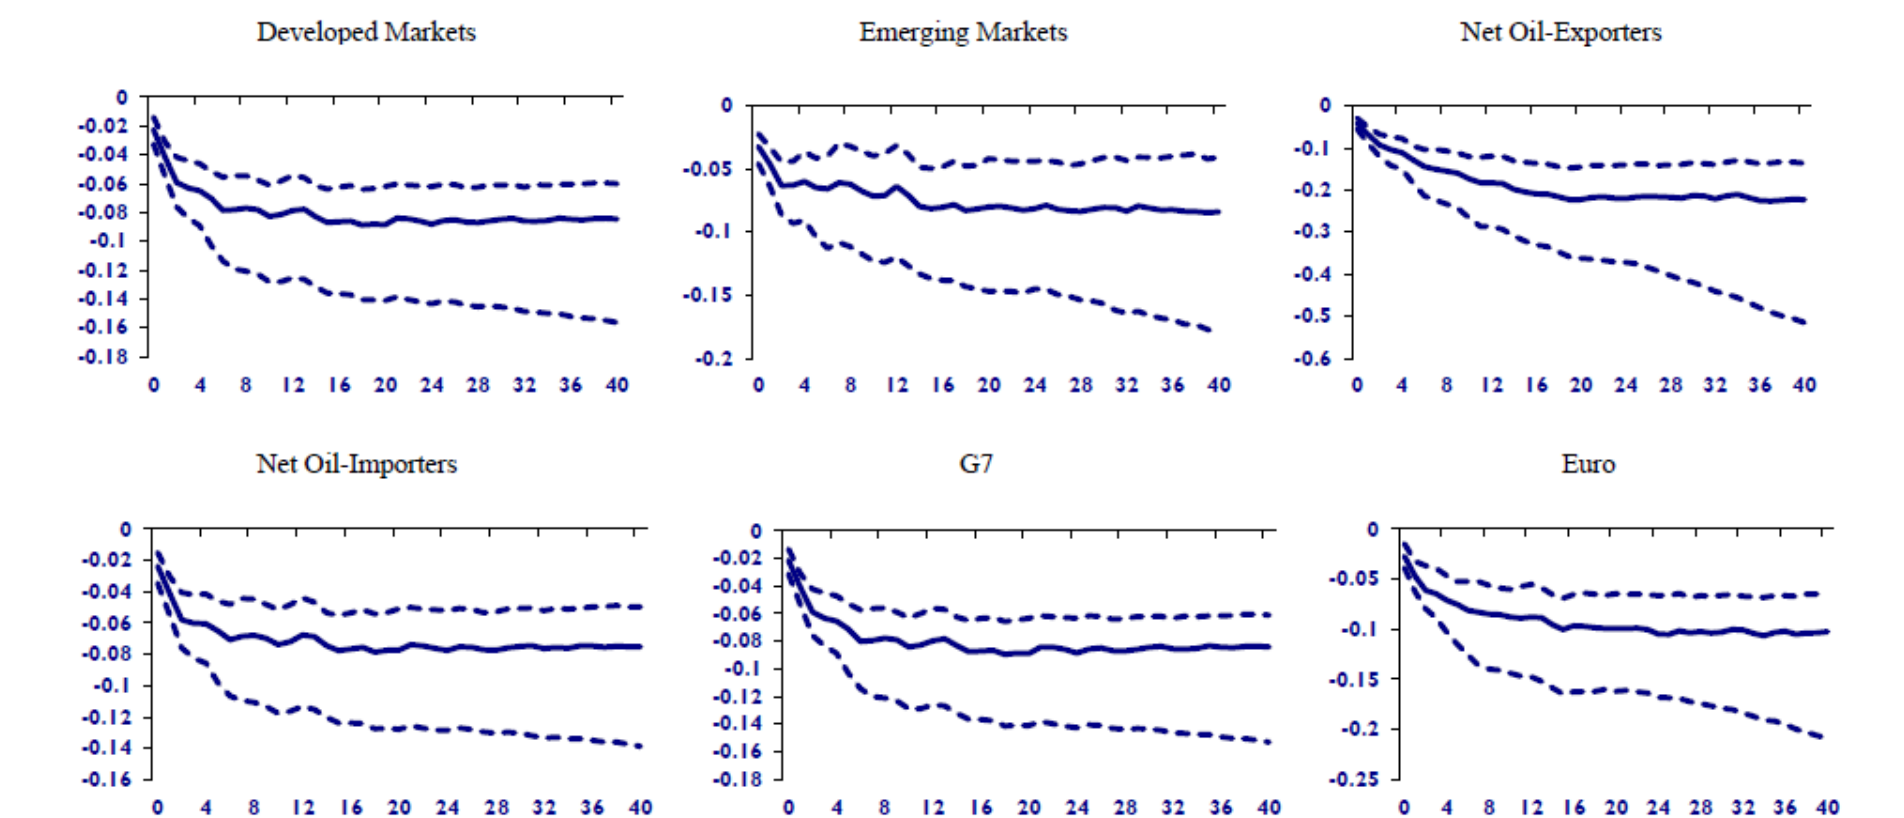
Figure 6. Country group oil price uncertainty shocks and real stock prices ( post-gfc ). Note: The figure depicts the impulse response functions of real stock prices of country groups to a one standard deviation increase in oil price uncertainty. The median impulse response is presented in solid lines, while the 16–84% lower and upper bootstrapped error bands are shown in dotted lines. The impact is measured in percentage points (by multiplying the estimates in the figure with 100) over the quarterly horizon.